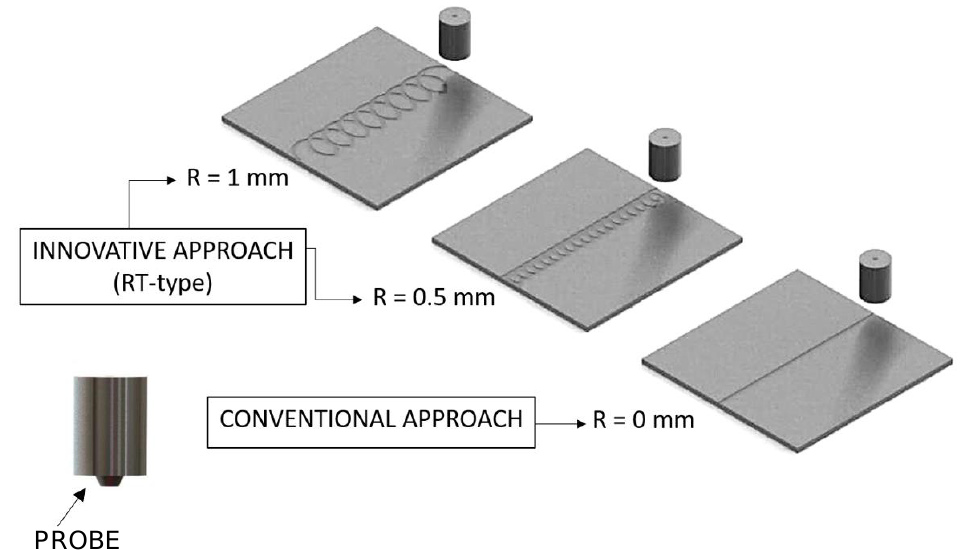
PROBE Figure 6. Tool photography and schematic view of the di ff erent FSW approaches Figure 6. Tool photography and schematic view of the different FSW approaches used.